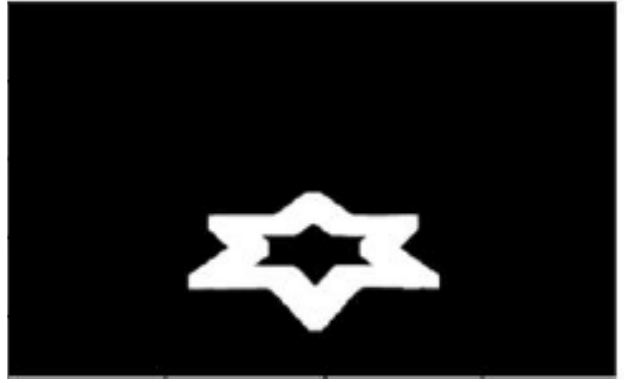
Figure 4. Example of the ROI that was used to extract the ratio of gaze points.